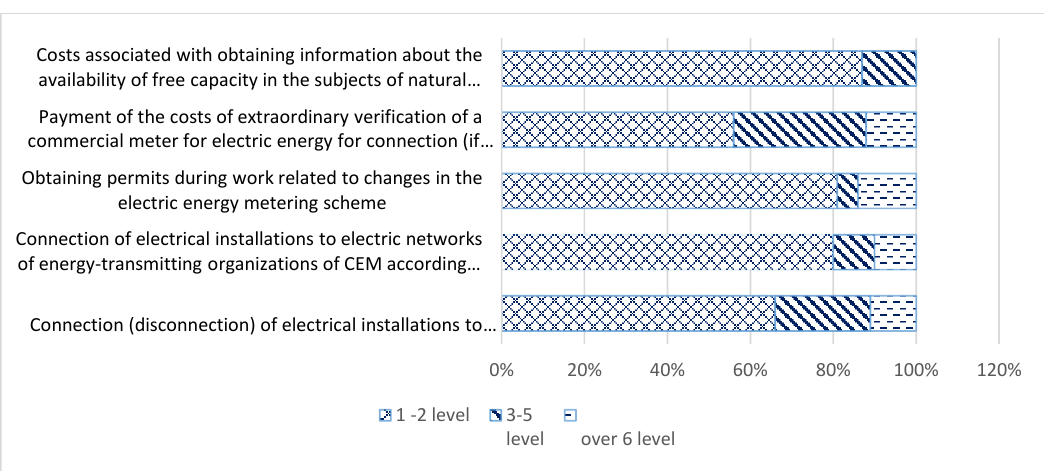
Figure 6 . Cost of services for connecting to elements of the power grid infrastructure. Source: personal elaboration.